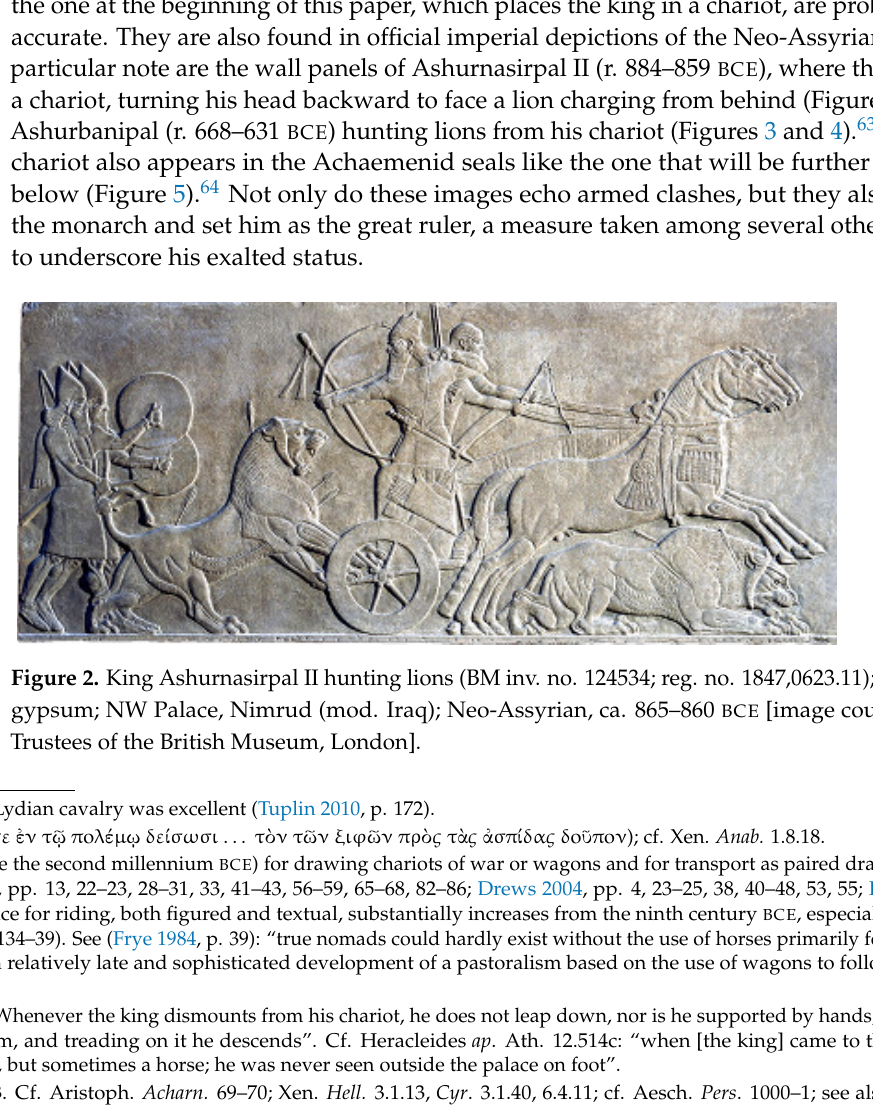
Figure 3. King Ashurbanipal hunting lions (BM inv. nos. 124850–51; reg. no. 1856,0909.15); relief scene (panels 20–21), gypsum; N Palace (Room C), Nineveh (mod. Iraq); Neo-Assyrian, ca. 645–635